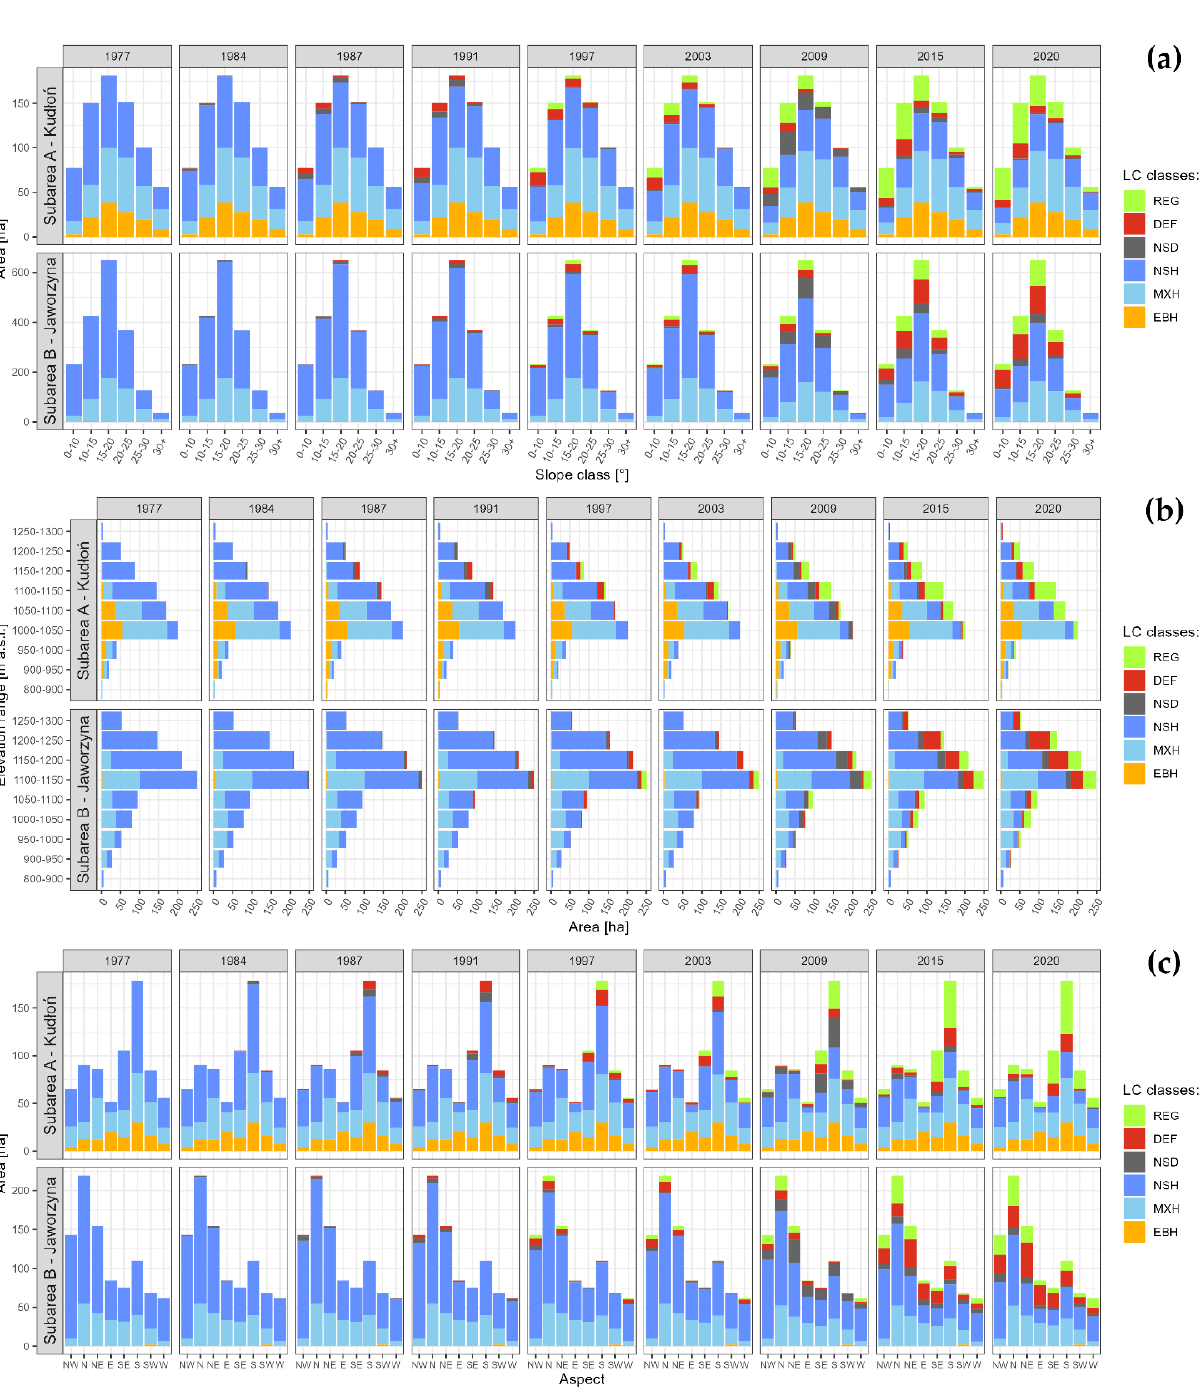
Figure 5. LC classes area in defined ( a ) slope classes ( b ) elevation zones ( c ) slope aspect classes in subarea A (the Kudłoń range) and subarea B (the Jaworzyna range). LC class abbreviations: REG: young forests on post-decline areas; DEF: deforested areas with fallen deadwood, forest gaps; NSD: standing, dead and severely damaged groups of Norway spruce trees; NSH: mature, healthy forest stands dominated by the Norway spruce; MXH mature, healthy mixed forest stands.